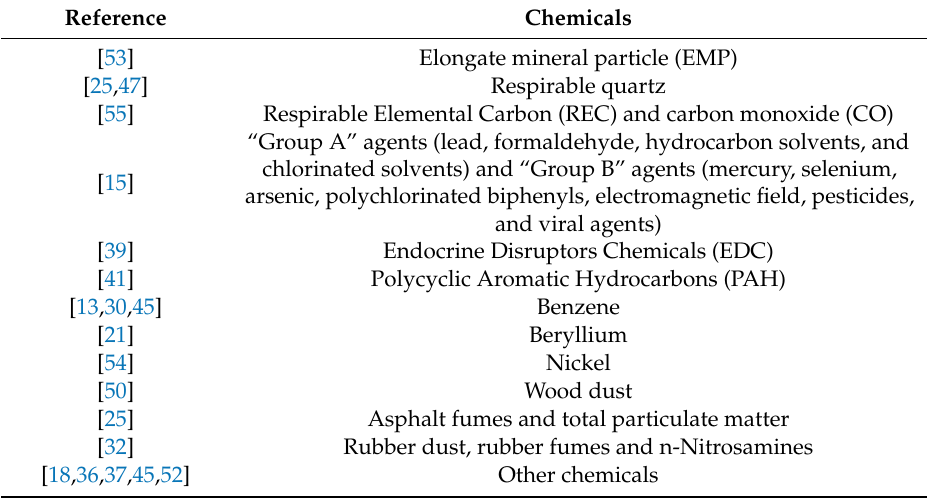
Table 4. Summary of chemicals considered in the studies under